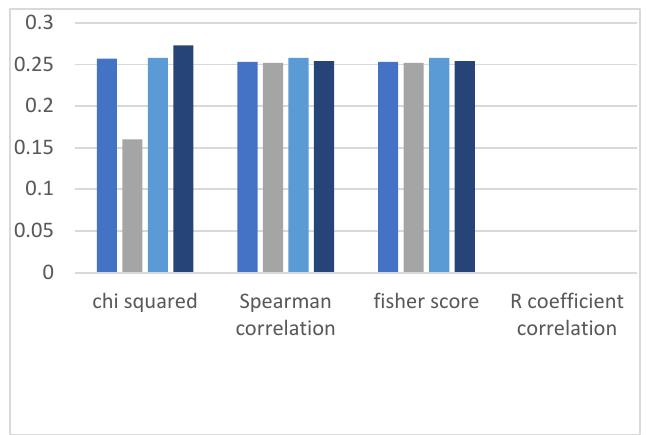
Figure 13. Recall using enhanced SVM.